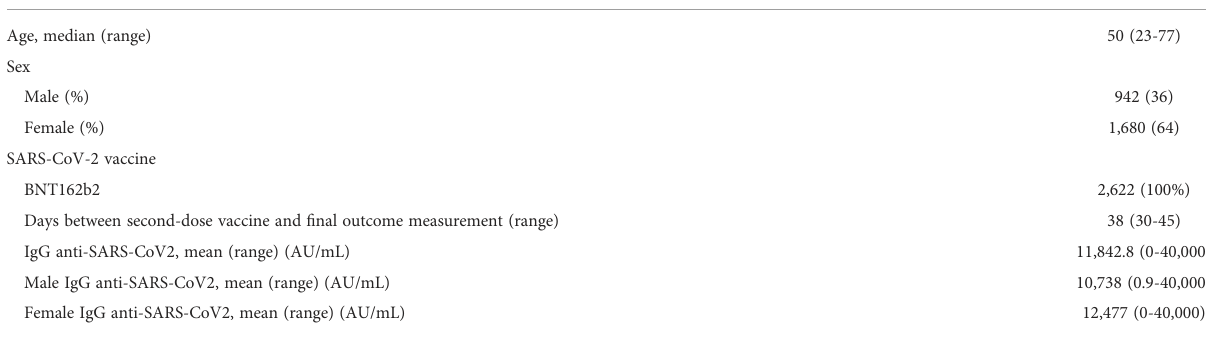
TABLE 2 Characteristics of the control